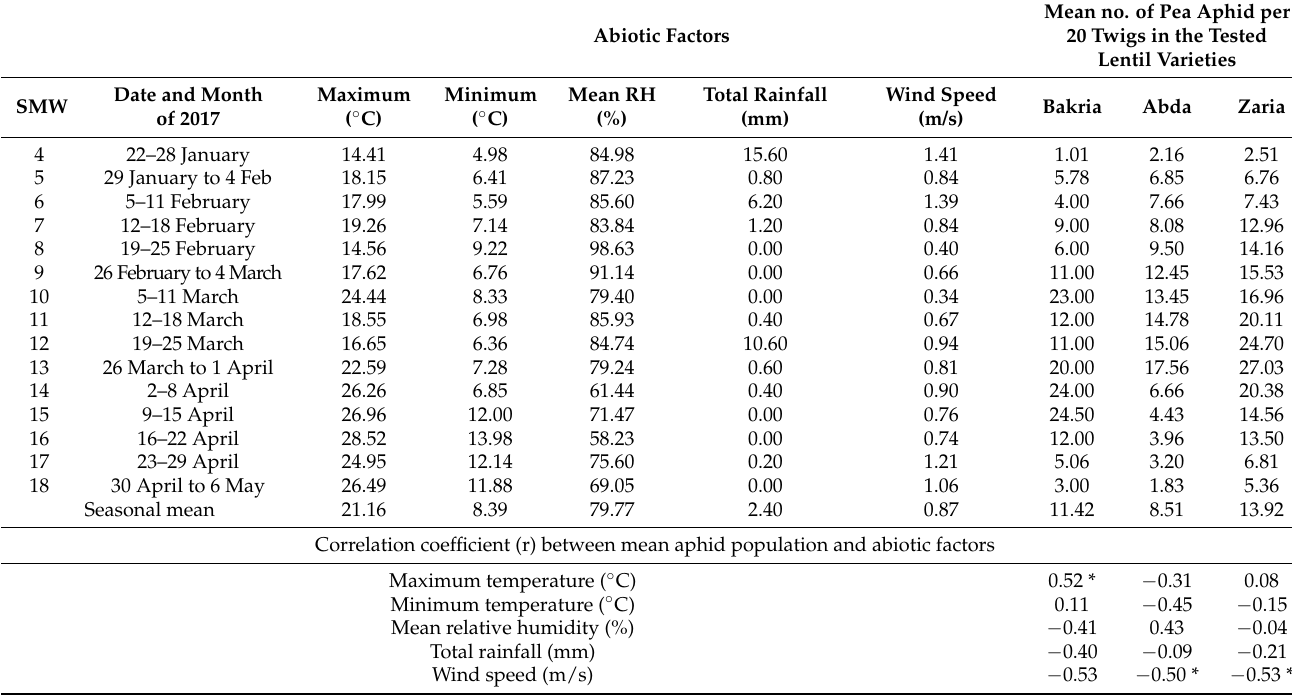
Table 6. Influence of weather factors on mean number of pea aphid, A. pisum , per 20 twigs of three lentil varieties during 2016–2017.